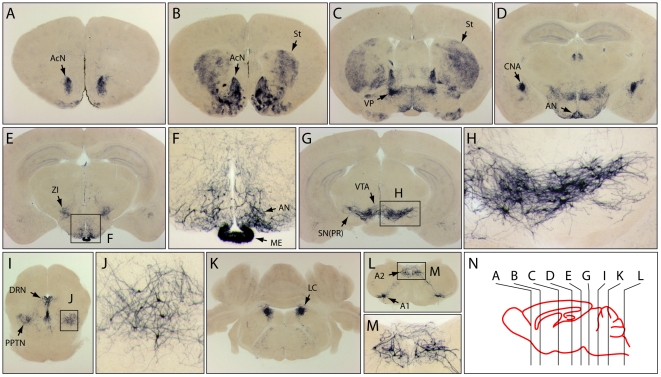
Survey of catecholaminergic neuronal morphologies and projections in the brain of TH-IRES-CreER;R26IAP mice.Animals were injected with 100 µg 4HT at P3. (A–E,G,I,K,L) 300 µm coronal sections at Bregma positions 1.7, 1.1, 0, −1.6, −2.2, −3.2, −4.7, −5.5, −8.2, respectively, as shown schematically in (N). (F,H,J,M) enlargements of boxed regions. A1, A1 noradrenergic cell group; A2, A2 noradrenergic cell group; AcN, accumbens nucleus; AN, arcuate nucleus; CNA, central nucleus of the amygdala; DRN, dorsal raphe nucleus; LC, locus coeruleus; ME, median eminence; PPTN, pedunculopontine tegmental nucleus; SN(PR), substantia nigra (pars reticulata); St, striatum; VP, ventral pallidum; VTA, ventral tegmental area; ZI, zona incerta.